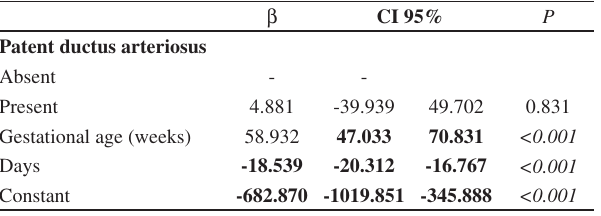
Table 8 - Generalized estimation equation (GEE) model to assess the association between total fluid intake during the first week of life and patent ductus arteriosus.